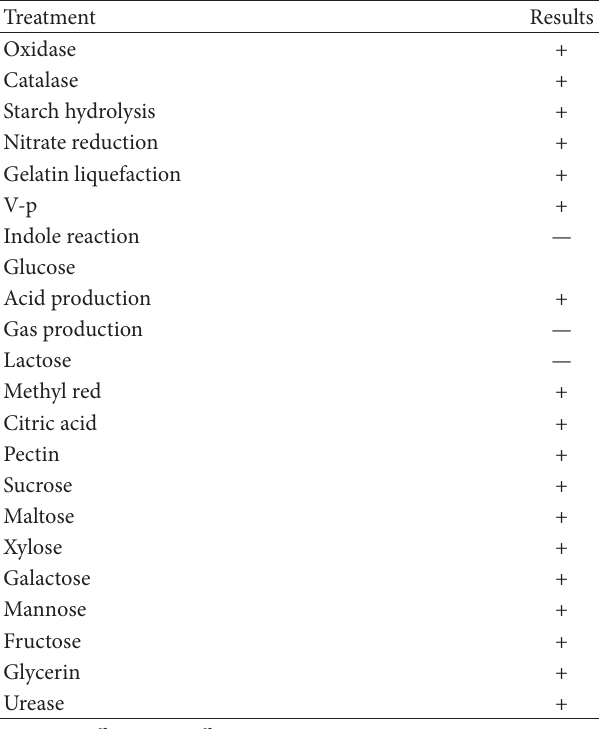
Table 4: Physiological and biochemical characteristics of strain B37. Treatment